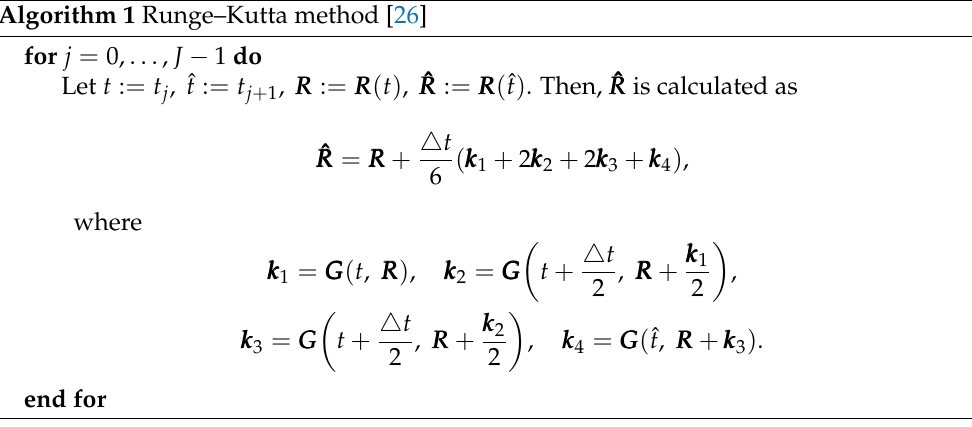
Algorithm 1 Runge–Kutta method